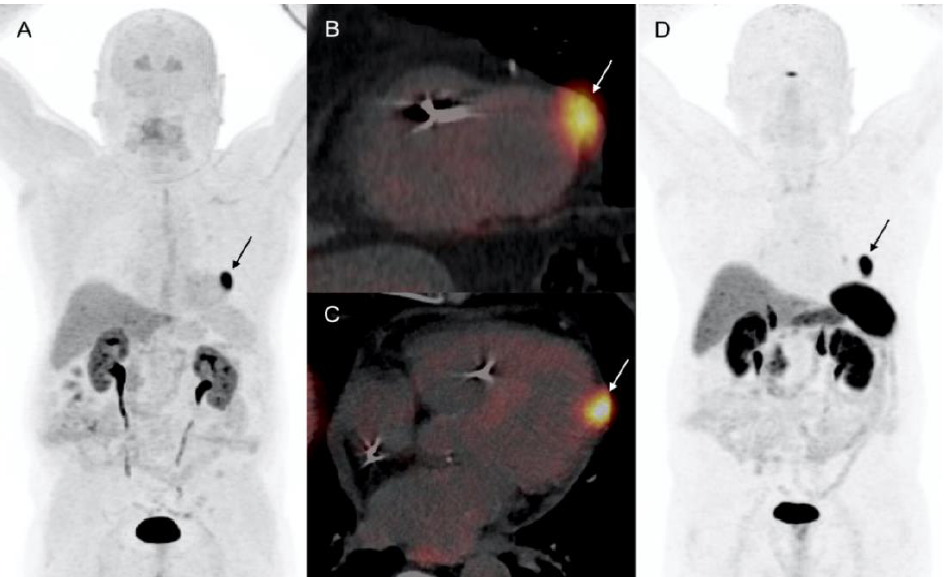
Figure 1. Patient 1. 72-year-old patient with metastatic si-NET. LV CM (arrows) showed intense uptake of both 18 F-DOPA and 68 Ga-DOTATOC. ( A ) 18 F-DOPA PET MIP (anterior projection). ( B , C ) 18 F-DOPA PET/CT short axis, and 4 chamber view. ( D ) 68 Ga-DOTATOC PET MIP (anterior projection).